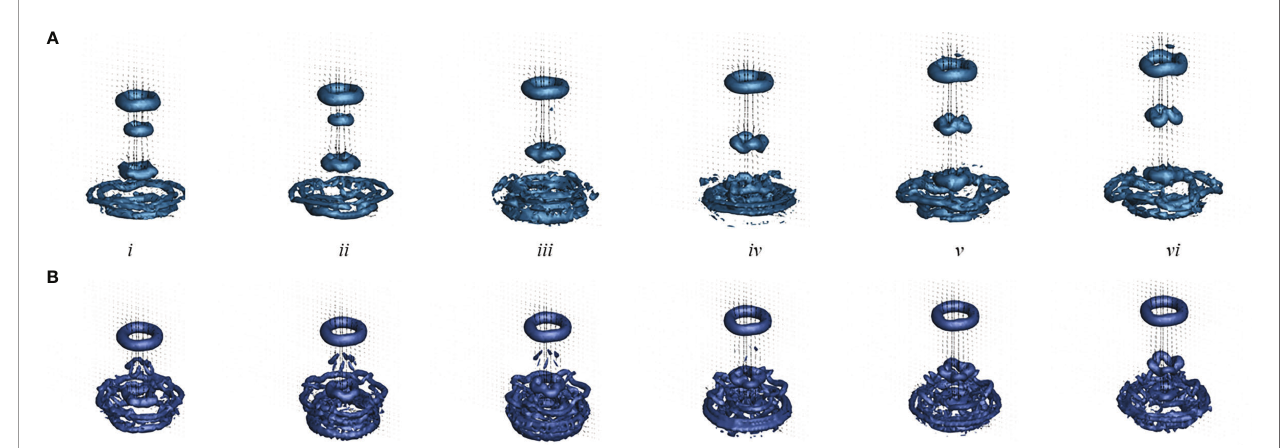
FIGURE 7 | Q – criterion isosurface of fl ow generated by pulsations of a numerical Cassiopea medusa with no oral arms where the isosurface is drawn at Q = 5 s -2 . Velocity vectors were extracted at a 2D slice through the center of the numerical bell. Numerical simulations include a medusa resting against the substrate ( A , top) and with no substrate ( B , bottom). Snapshots show the beginning of the fourth stroke cycle (i) and 20%, 40%, 60%, 80%, and 100% through the stroke cycle